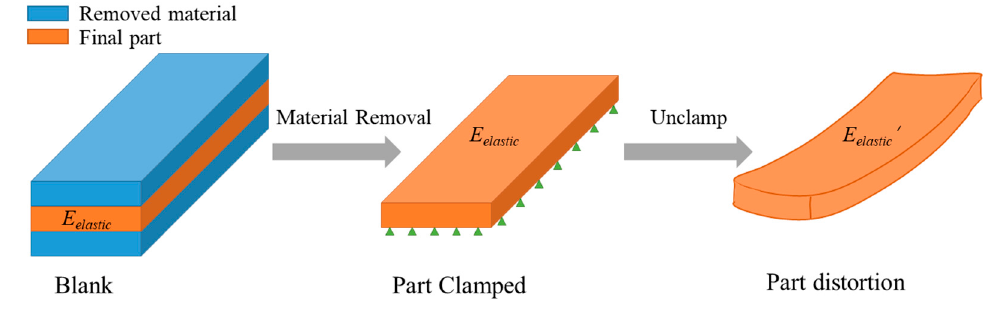
Figure 1. Energy release mechanism of machining distortion.